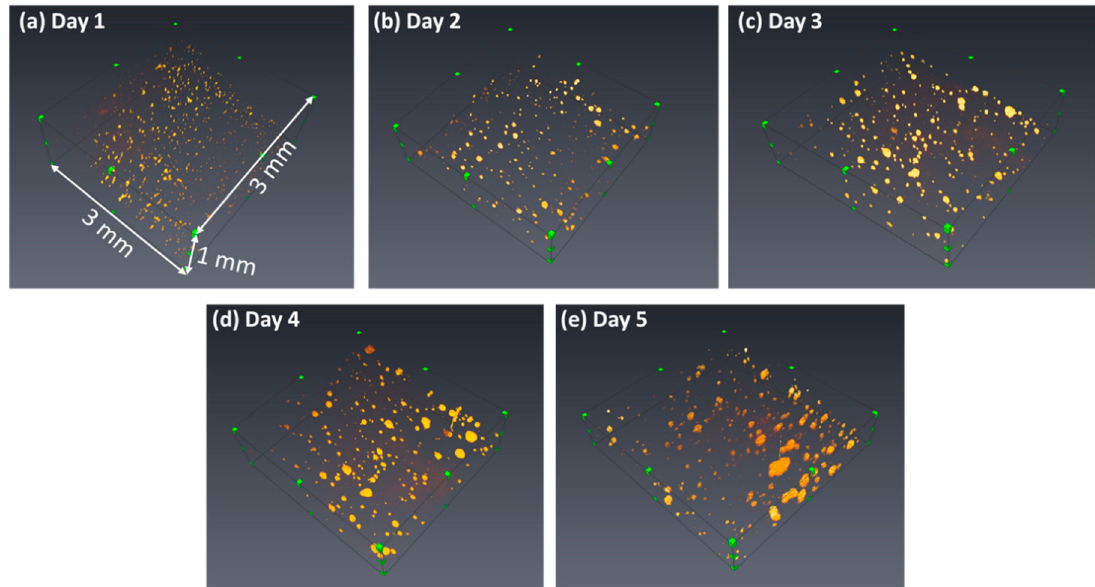
Figure 6. Corresponding 3D OCT images of cell colonies obtained at the time points of Day ( a ) 1, ( b ) 2, ( c ) 3, ( d ) 4, and ( e ) 5, respectively.